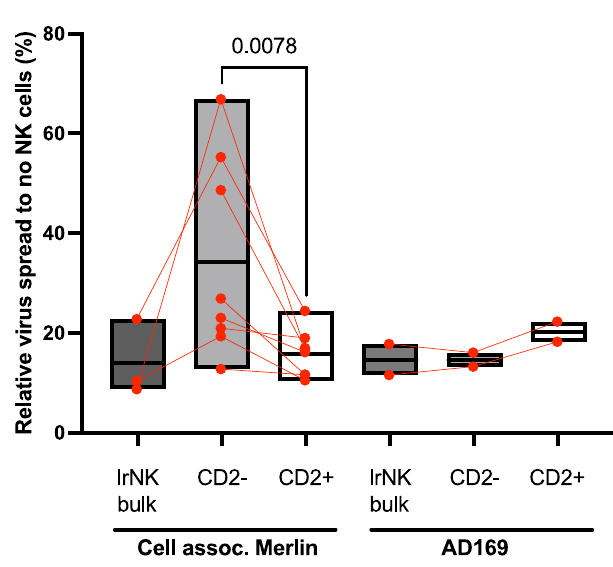
Fig. 5 | CD2+lrNK cells control HCMV replication. Bulk lrNK cells or lrNK cells separated into CD2+and CD2- fractions were analysed for their ability to control differentHCMVstrains in avirusdisseminationassay(cellassoc. Merlin (individual donor n =8)or AD169 (individual donor n =2)).Dataare presented as fl oating bars with individual values and showing mean values. Experiments were run once for eachdonor.Signi fi cancewasassessed using atwo-tailed Mann-Whitney U testwith P valueslessthan0.05consideredsigni fi cant.SourceDataareprovidedasaSource Data fi le.